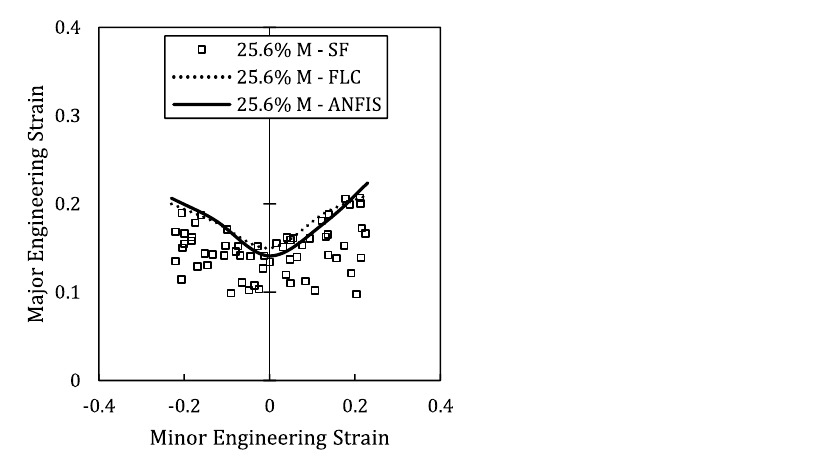
Figure 11. Schematic of ANFIS layers for two inputs and one